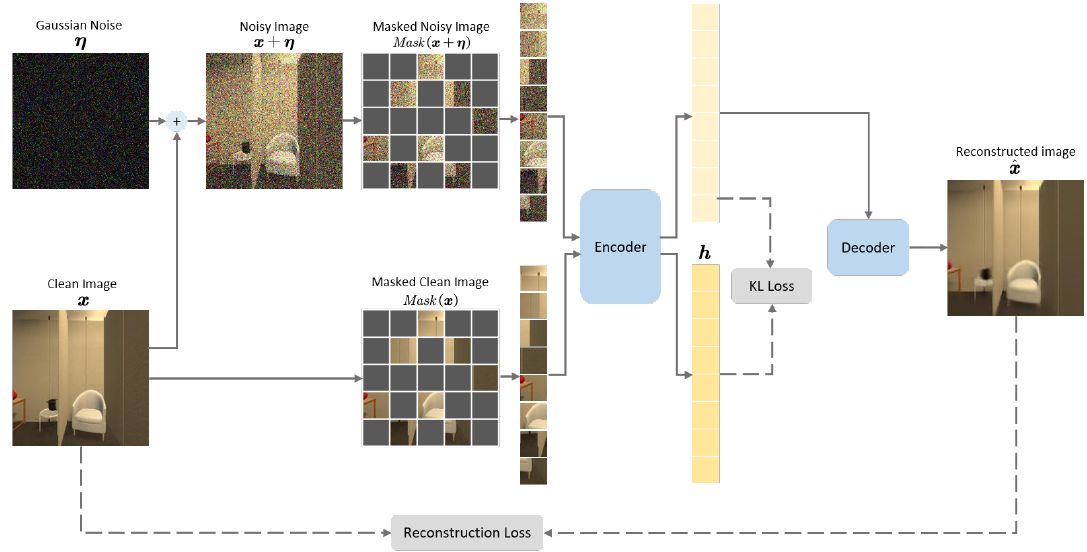
Figure 3. Illustration of RDMAE